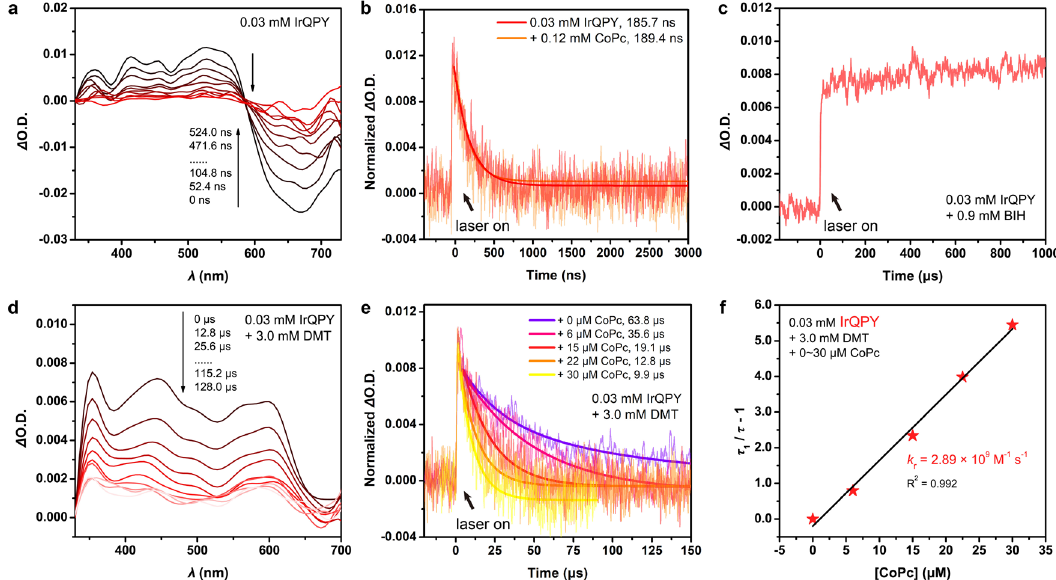
Fig. 6 Transient absorption spectroscopy. a TA spectrum of 0.03 mM IrQPY. b TA decay traces of 0.03 mM IrQPY in the absence (red) or presence (orange) of 0.12 mM CoPc at 530 nm. c TA decay trace of 0.03 mM IrQPY in the presence of 0.9 mM BIH at 350 nm. d TA spectrum of 0.03 mM IrQPY in the presence of 3.0 mM DMT. e TA decay traces of 0.03 mM IrQPY with 3.0 mM DMT in the absence (violet) or presence of 6 (pink), 15 (red), 22 (orange), 30 (yellow) μ M CoPc at 350 nm. f Plot of ( τ 1 / τ − 1) versus [CoPc] with linear fi tting for the IrQPY system. The excitation wavelength is 355 nm.